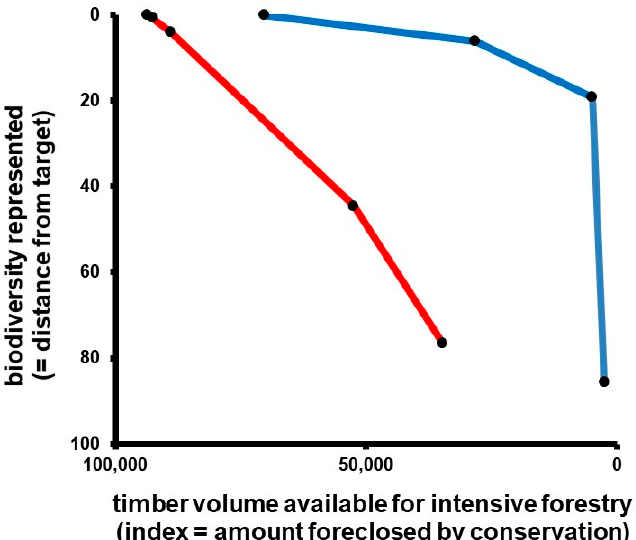
Figure 1. Efficiency-frontier curves for PNG indicating best possible combinations of biodiversity conservation level (vertical axis) and total timber volume available to forestry (horizontal axis). Points along the curves represent different allocations of the country’s RMUs to either conservation or (avail- ability for) forestry production. Allocations of RMUs offering both high biodiversity conservation and high forestry production are towards the upper right corner. Red curve: approximate efficiency frontier curve under all constraints, following [16], including required inclusion of all WMAs in the selected set. Upper point corresponds to the set discussed in [16] (Table 5), where the biodiversity target is met, with forestry-related opportunity cost of conservation of approximately 93,000 units. Other points along the curve correspond to reduced importance weight on biodiversity, relative to forestry. The blue curve represents the approximate efficiency frontier curve under all constraints, but without required inclusion of all WMAs in the selected set. The upper point corresponds to a set where the biodiversity target is met, with forestry-related opportunity cost of conservation of approximately 71,000 units. Other points along curve again correspond to reduced importance weight on biodiversity, relative to